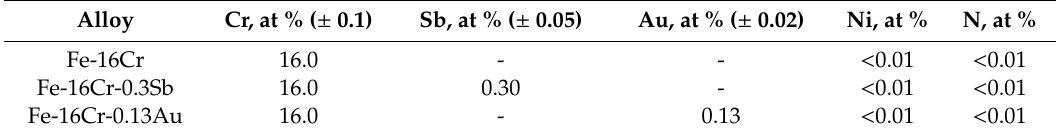
Table 1. Composition of Fe-Cr